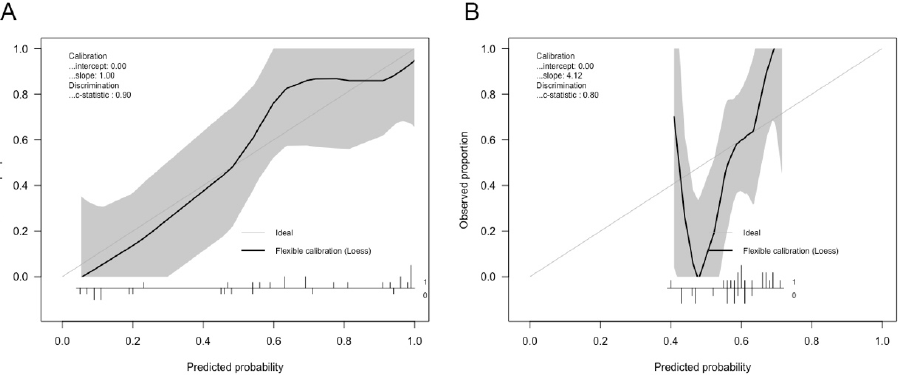
Figure 5. Calibration plot of HU feature-based models in discriminating intracranial hypertension in unilateral TBI patients: ( A ) calibration plot of logistic regression HU feature-based model; ( B ) calibration plot of regularized version of the model. In the three classifications of ICP (ICP ≤ 22, 23–29, and ≥ 30 mmHg), the CE model failed to predict intracranial hypertension from the CT slide according to the